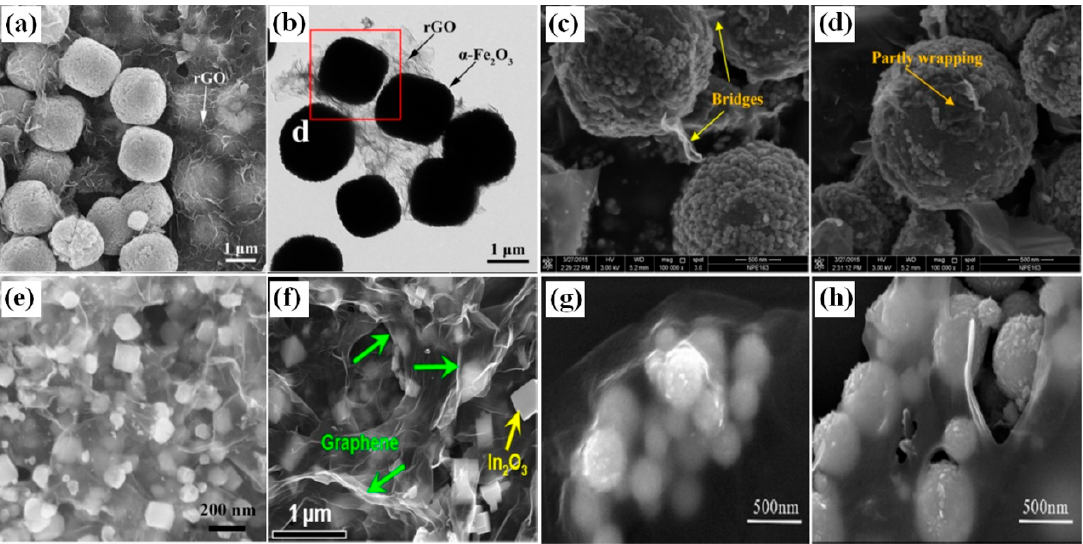
Figure 6. Morphology of ( a–b ) rGO/ α -Fe 2 O 3 cubic nanostructure [74]; ( c–d ) rGO decorated TiO 2 microspheres [78]; ( e ) N-rGO/NiO cube [75]; ( f ) rGO/In 2 O 3 cube nanocomposites [76]; ( g–h ) graphene-wrapped WO 3 nanospheres [79]. ( a–b ), (c–d) and ( g–h ) were reproduced with permission from [74,78,79], © Elsevier. ( e ) and ( f ) were reproduced with permission from [75,76] © American Chemical